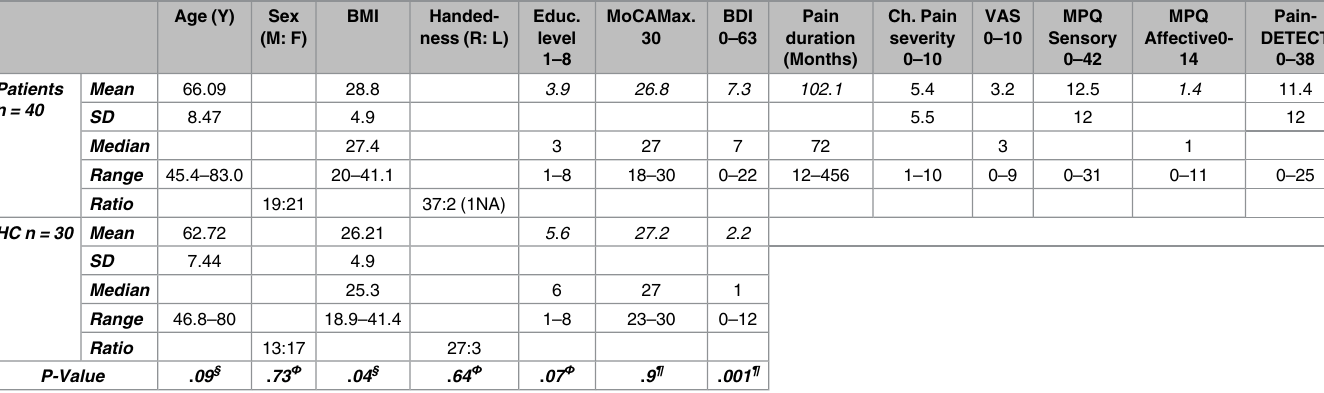
Table 1. Characteristics of study